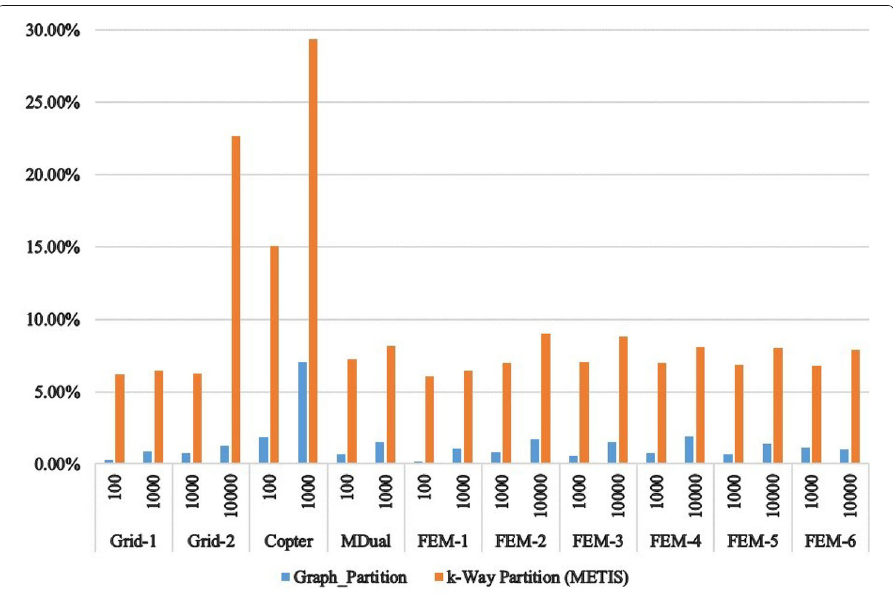
Fig. 8 The experimental results on unbalanced